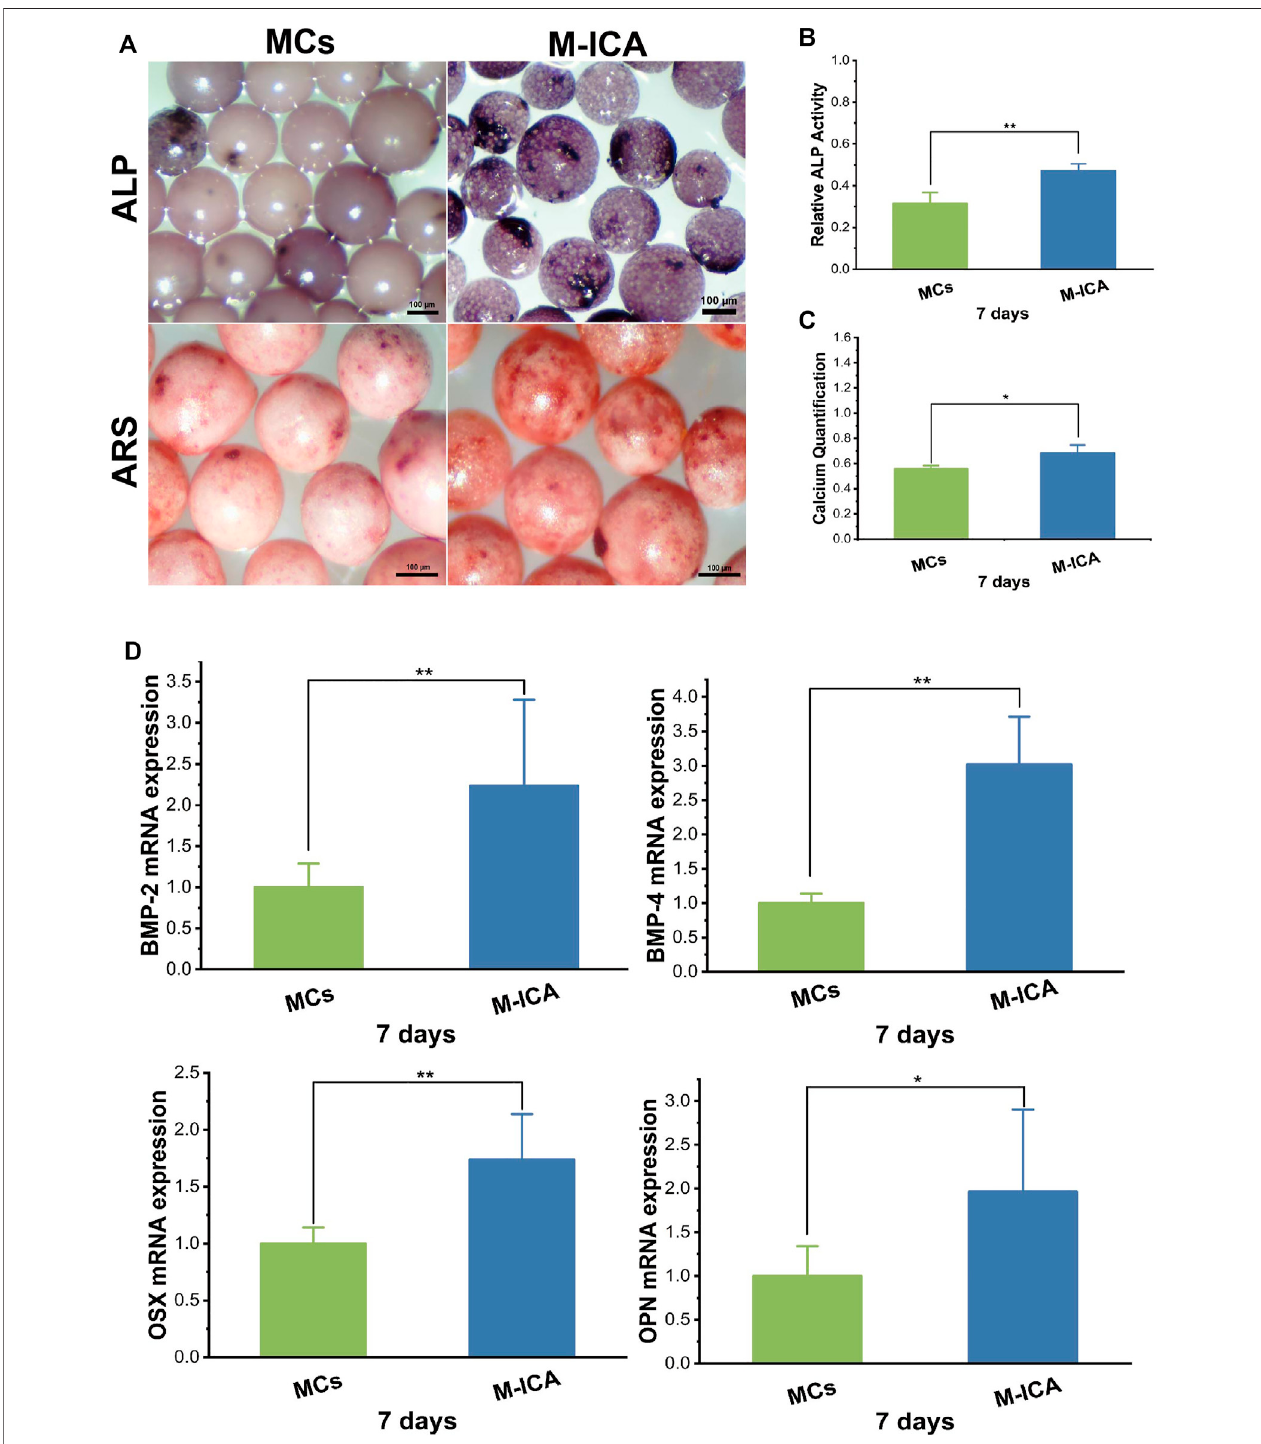
FIGURE 5 | (A) ALP and ARS staining of BMSCs cultured for 7 days on MCs and M-ICA (Scale bar = 100 μ m). The corresponding ALP quantitation (B) and correspondingcalciumdepositionquantitation (C) ofBMSCsculturedfor7daysonMCsandM-ICA. (D) qRT-PCRanalysisofBMP-2,BMP-4,OSXandOPN(* p < 0.05, ** p < 0.01, n =